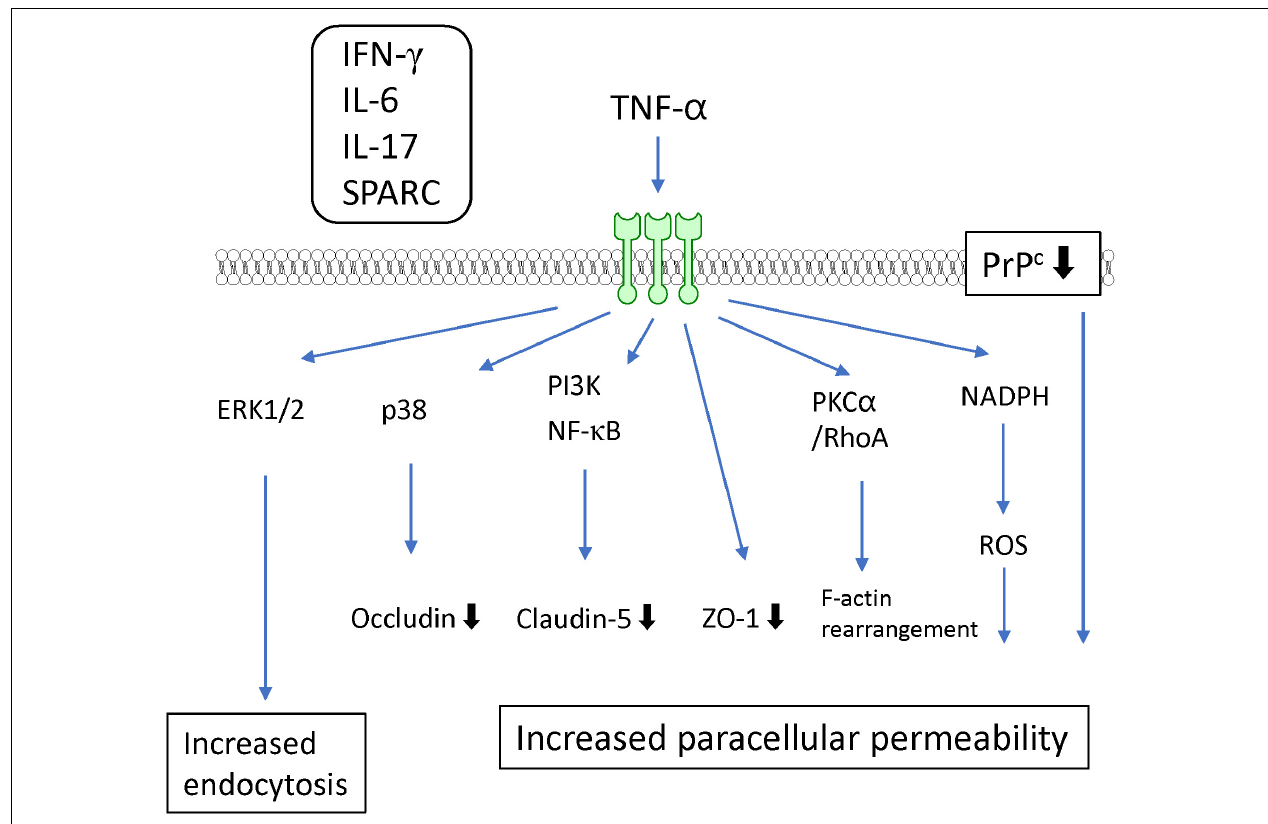
FIGURE 4 | Intracellular signaling pathways induced by TNF- α in BMECs leading to BBB dysfunction. TNF- α induced release of IFN- γ , IL-6, IL-17 and SPARC by BMECs. They contribute to TNF- α -induced BBB